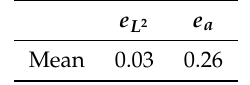
Table 7. Percentage error of multiscale solution u ms in experiment